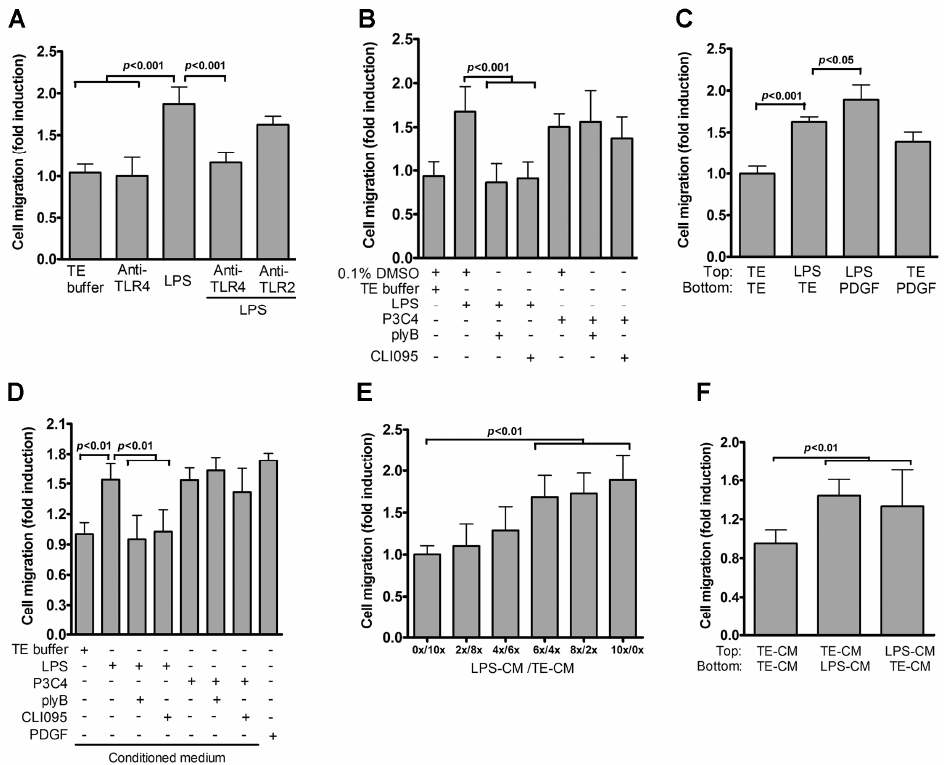
Figure 2. Role of TLR4 in VSMC migration. ( A ) VSMCs (in the presence or absence of anti-TLR2 or anti-TLR4 antibodies (5 μ g/mL)) were treated with TE buffer or LPS for 24 h; ( B ) Quiesced VSMCs were stimulated with TE buffer, LPS or P3C4 in the presence or absence of plyB or CLI095 for 24 h. Migration assays were then performed with PDGF-BB as a chemoattractant. p < 0.001 vs. LPS or LPS + DMSO; ( C ) Serum-starved VSMCs were seeded into the upper chambers of transwell plates and stimulated with TE buffer or LPS for 24 h. Migration assays were then performed with or without PDGF-BB as a chemoattractant. p < 0.001 for LPS vs. TE. p < 0.05 for LPS vs. LPS + PDGF; ( D ) Conditioned medium from VSMCs stimulated with TE buffer, LPS or P3C4 with or without plyB or CLI095 for 24 h was collected and added to the lower chamber as a chemoattractant in the transwell migration assays. PDGF-BB was used as a positive control. p < 0.01 vs. LPS; ( E ) Serial dilutions of conditioned medium (CM) from VSMCs stimulated with LPS (LPS-CM) were prepared by diluting with TE-treated CM (TE-CM) and added to the lower chambers; VSMCs were plated onto top chambers of transwells. After 24 h incubation, VSMC migration was determined by the transwell assay. p < 0.01 vs. 0x/10x; ( F ) Checkerboard assays. CM from VSMCs treated with TE buffer (TE-CM) or LPS (LPS-CM) for 24 h was added either to the upper or lower chamber of the transwell plates for VSMC migration assays. p < 0.01 vs. TE-CM/TE-CM. Data in A – F represent mean ± SD of three experiments. Statistical analyses were performed using the one-way ANOVA.